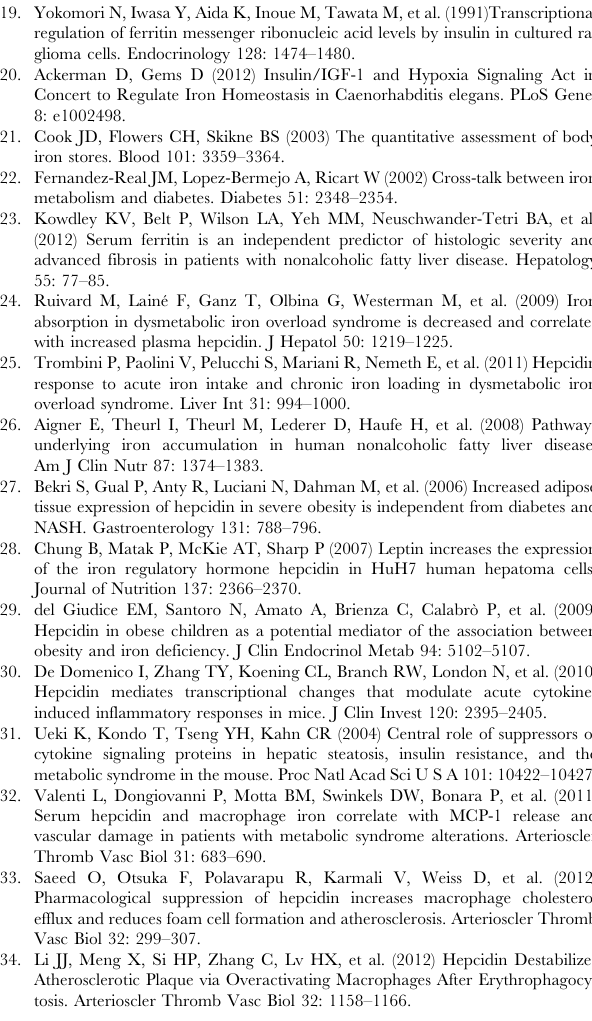
Figure S3 Correlation between hepcidin-25 and ferritin. (TIF) Figure S4 Hepcidin levels in females according to ferritin levels and presence/absence of MetS. (TIF) Figure S5 Prevalence of MetS in females according to hepcidin levels (A), and the relative ORs for MetS, adjusted for age and ferritin (B). (TIF) Table S1 Prevalence of MetS features in the VB population.